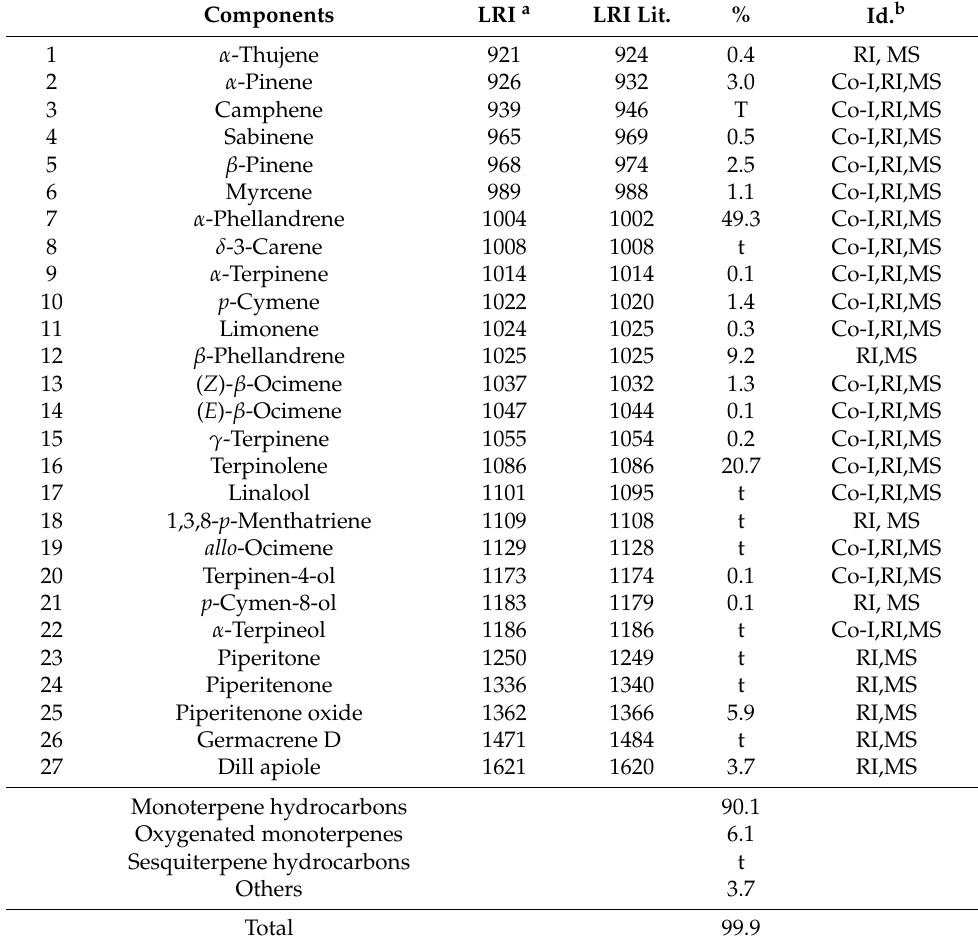
Table S1 reviews the composition of EOs of different accessions of R. segetum studied so far (Supplementary Material). Table 1. Composition (%) of the essential oil of flowers of Ridolfia segetum collected in Sicily.